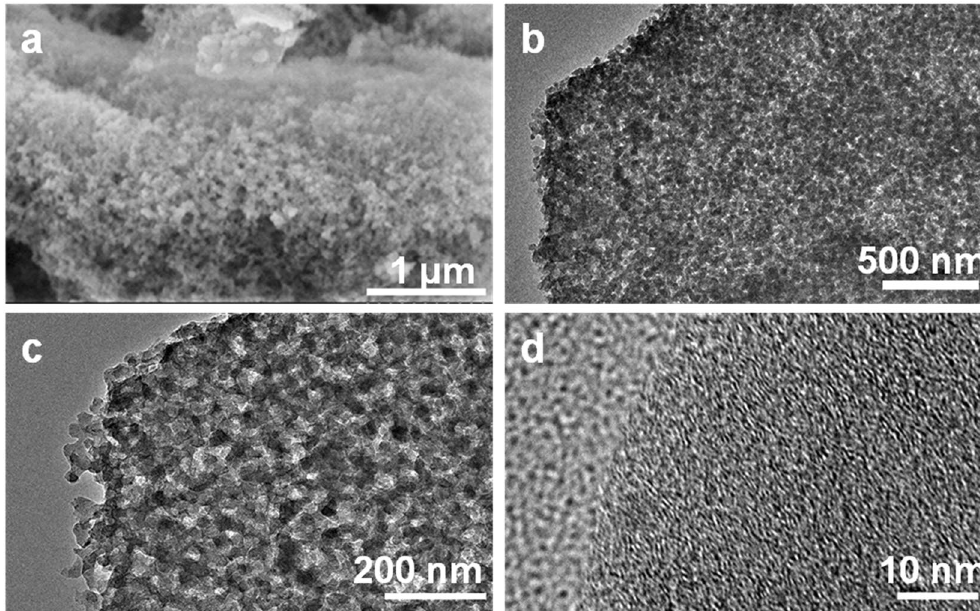
Figure 2. ( a ) SEM, and ( b – d ) TEM images of BPC with different magnifications.